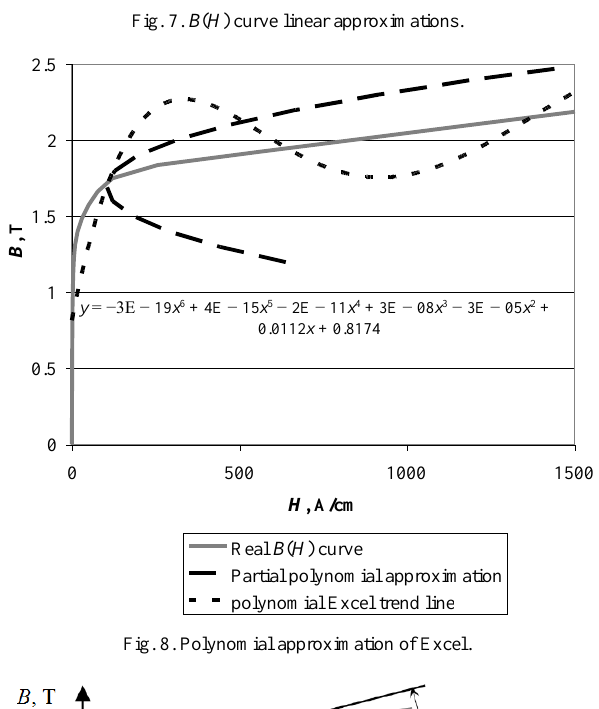
Fig. 7. B ( H ) curve linear approximations.